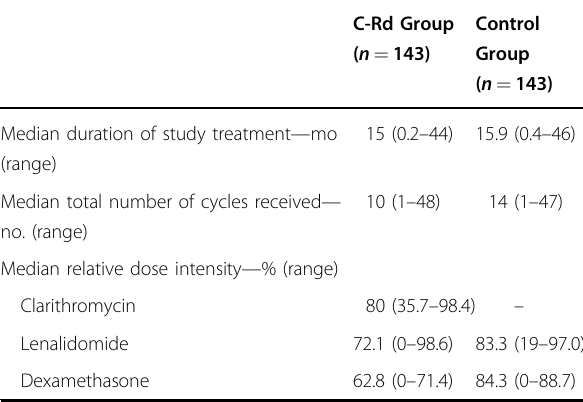
Table 5 Treatment exposure in the safety